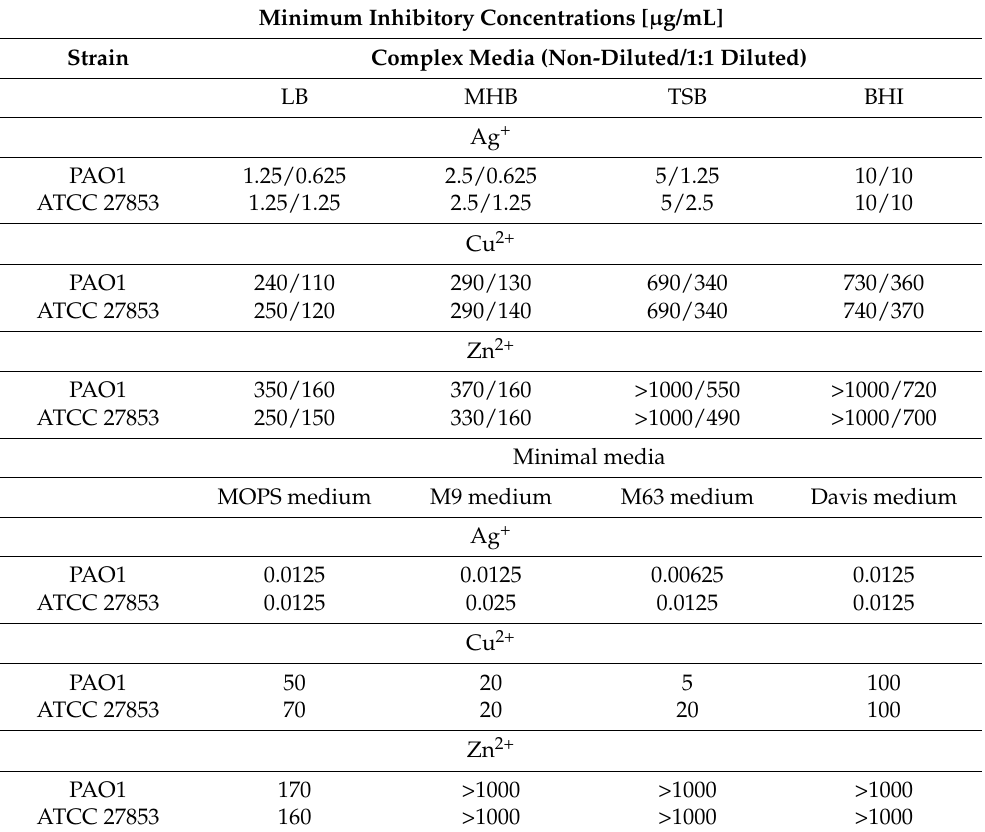
Table 1. Comparison of Ag + , Cu 2+ and Zn 2+ MICs in tested complex and minimal